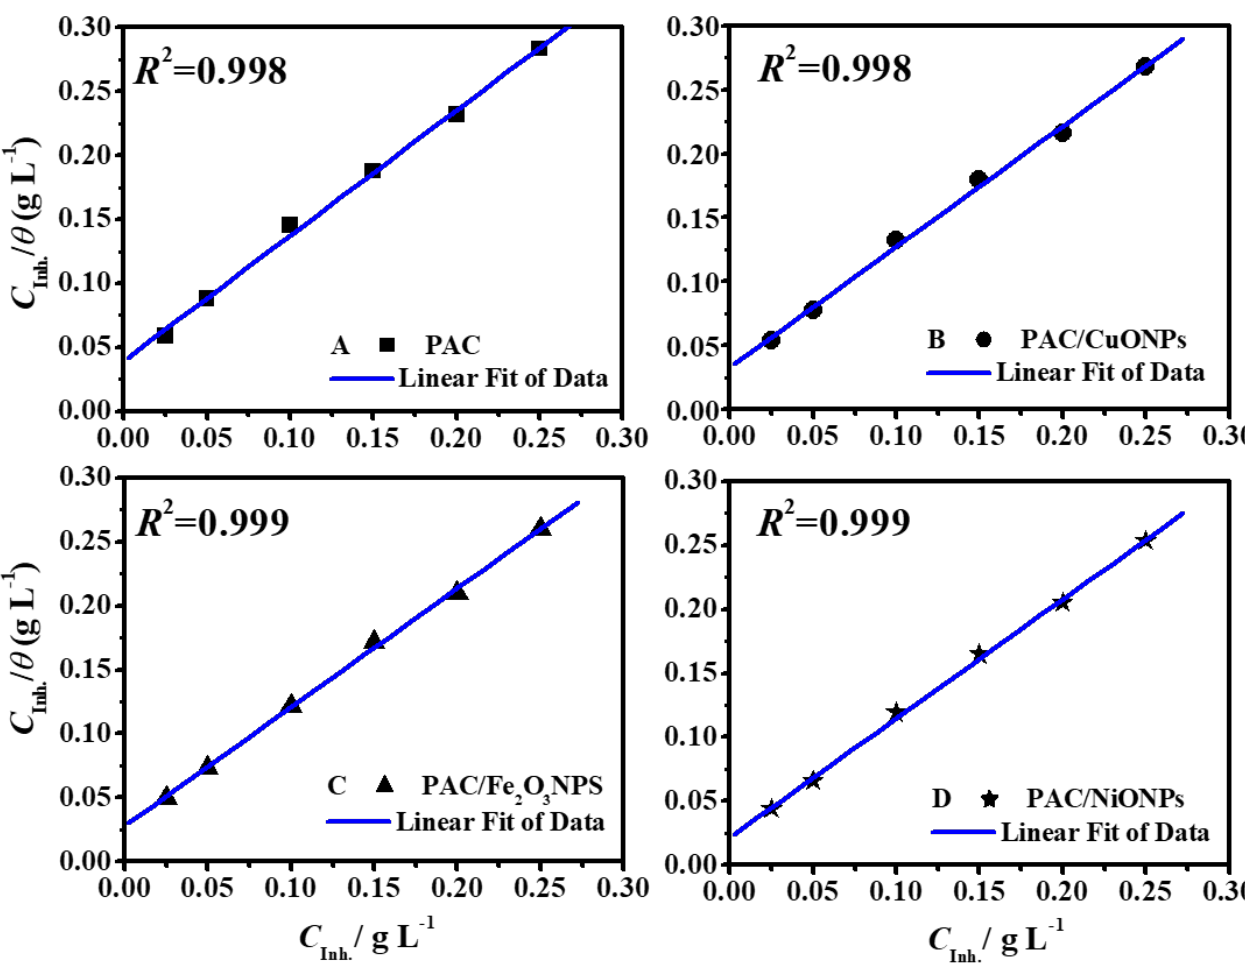
Figure 10. Langmuir profile of C/ θ vs. C from potentiodynamic polarization (PDP) findings for C-steel in 1.0 M HCl solu- tion in the presence of ( A ) PAC, ( B ) PAC/CuONPs, ( C ) PAC/Fe 3 O 4 NPs, and ( D ) PAC/NiONPs at 50 °C. Table 3. Adsorption parameters derived from Langmuir model for C-steel in molar HCl for PAC /MONPs at 50 °C using PDP outcomes.